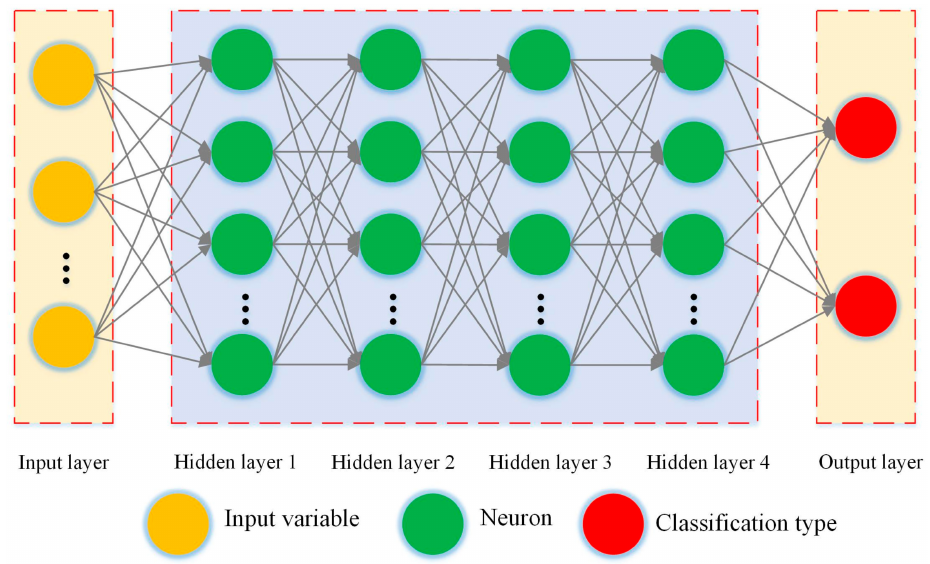
Figure 2. Architecture of the neural network employed for monkeypox